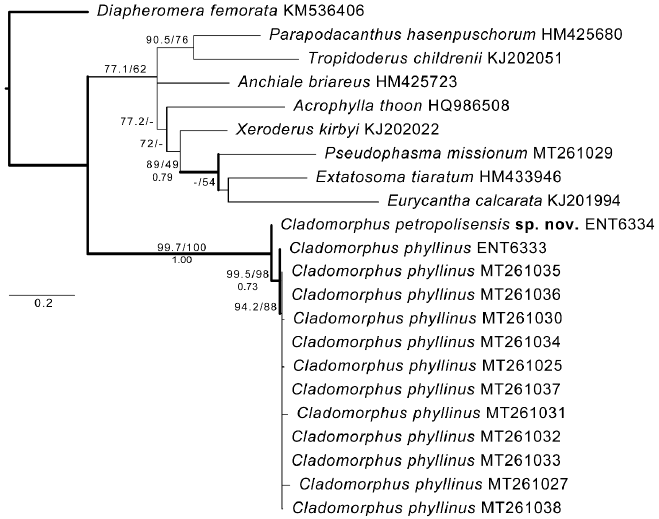
Figure 1. Maximum likelihood tree ( − lnL = 2892.3608) of COI sequences (618 bp) of Cladomorphus phyllinus and C. petropolisensis sp. nov. Thicker branches were also recovered in Bayesian inference analysis. Clade support (over >50%) associated to nodes are: SH-aLRT/UFBoot above and BPP below.